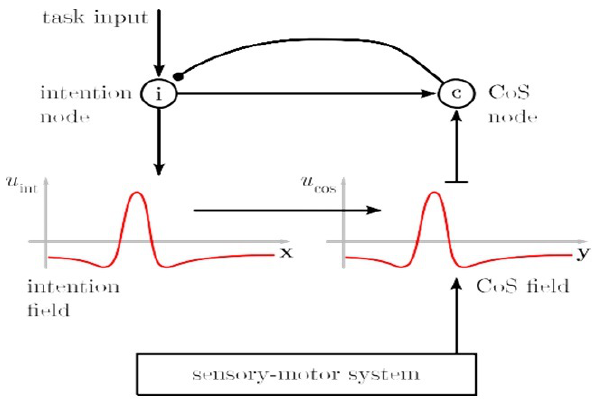
Figure 1: Schematic representation of a generic elementary behav-